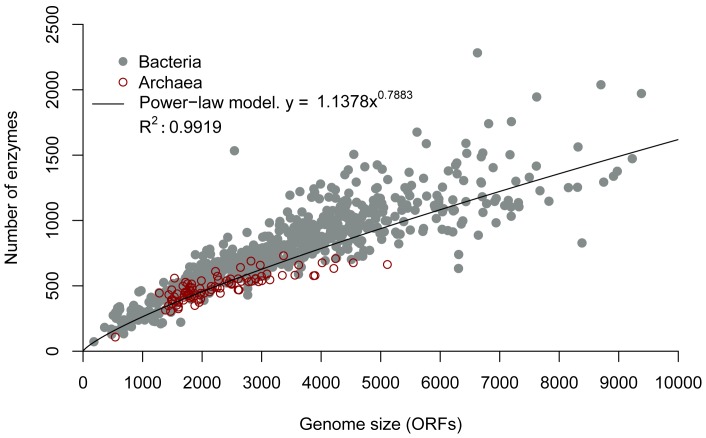
Abundance of enzymes as a function of genome size.On the x axis, genomes are sorted by the number of ORFs. The abundance of enzymes for each genome is shown on the y axis. Each dot corresponds to one genome. Bacteria and Archaea genomes are indicated by gray and filled or red and empty dots, respectively. The power-law function (black line) and R2 adjustment are also indicated y = 1.1378x
0.7883.